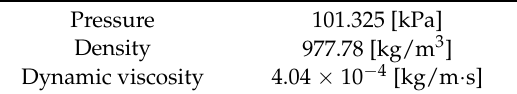
Table 4. Water properties.